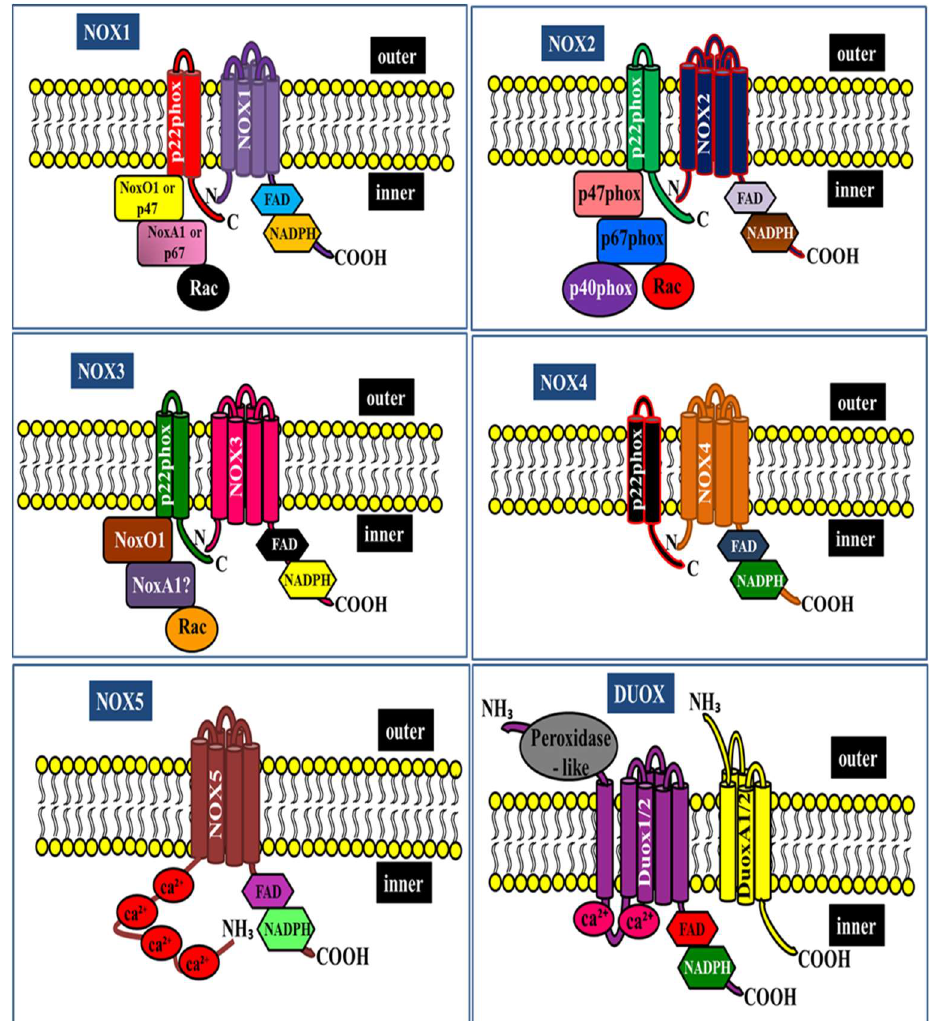
Figure 1. NADPH oxidase family structure and its subunits.